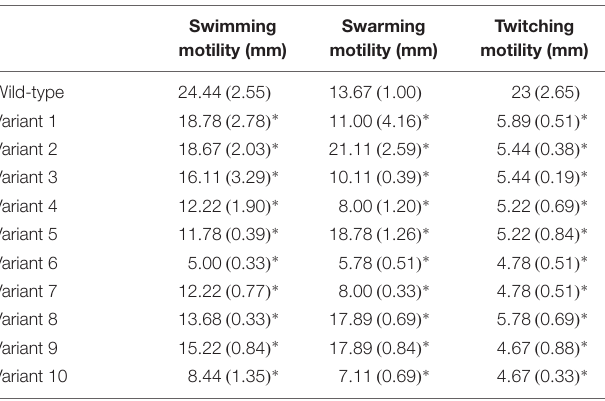
TABLE 2 | Motility assays of P. aeruginosa PAO1 wild-type (wt) and variants (1–10) [avg. ( ± SD)] (three independent experiments were